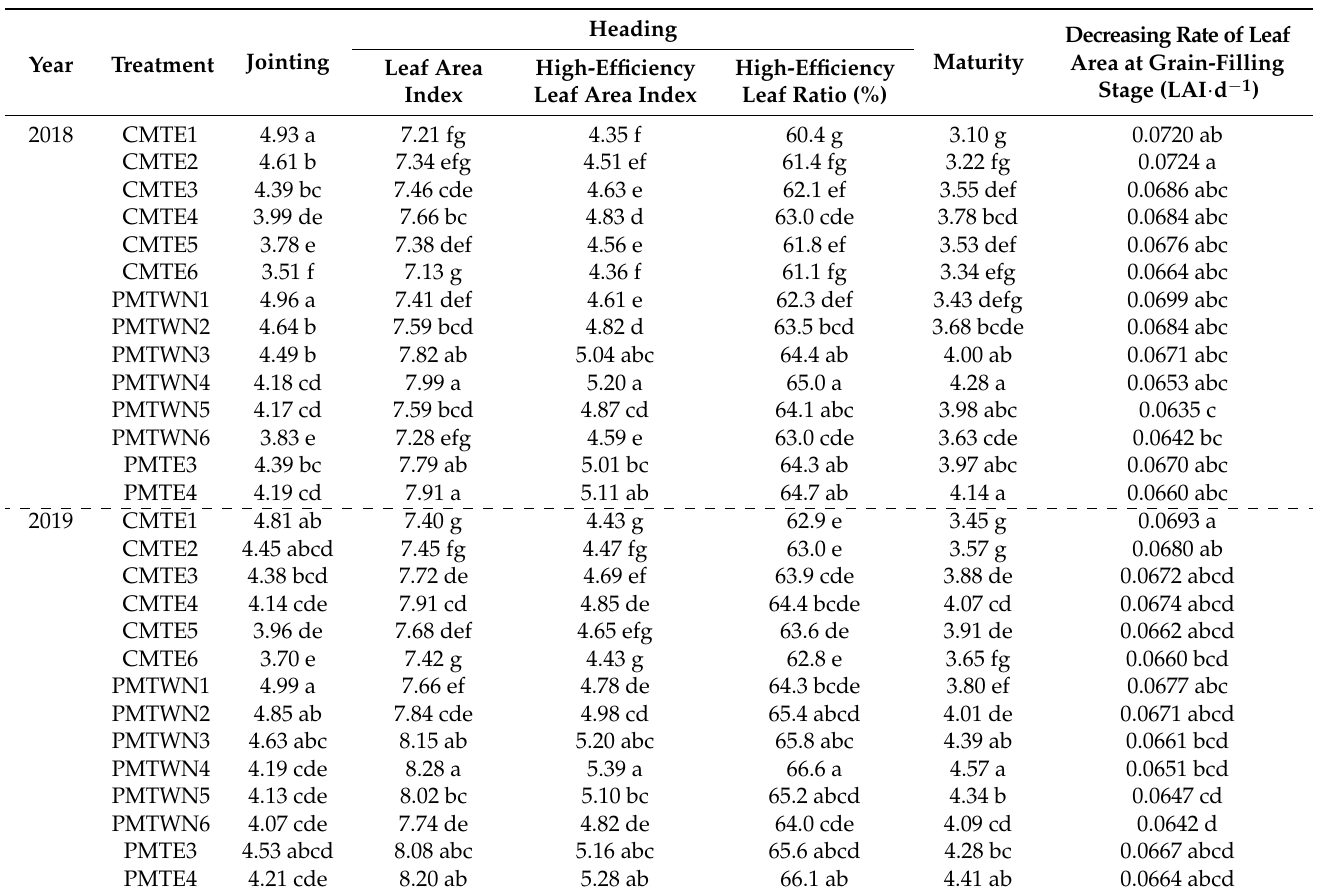
Table 3. Leaf area index and decreasing rate of leaf area during grain-filling stage of rice under different mechanical transplanting methods and planting